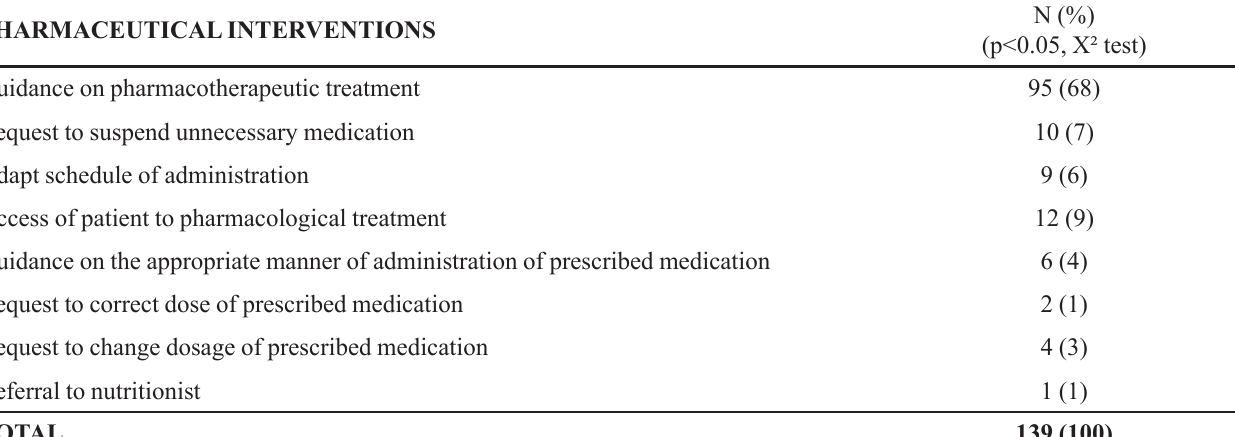
TABLE VI - Pharmaceutical interventions (n=139) (P8a) performed bythe Pharmaceutical Care Service for kidney and liver transplant patients in the period of April – October/2011 in Fortaleza – Ceará